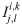
Depiction how accessibility-based approaches score an interaction of two RNAs S1 and S2 in orange and blue, respectively.The final interaction energy Ij,li,k is only defined for subsequence combinations enclosed by two intermolecular base pairs (i,j),(k,l), marked in black. It is composed of the duplex contribution Dj,li,k (via intermolecular base pairs), shown in grey and the energy needed to break the intramolecular base pairing of each subsequence, i.e., ΔE1+ΔE2, depicted in red.